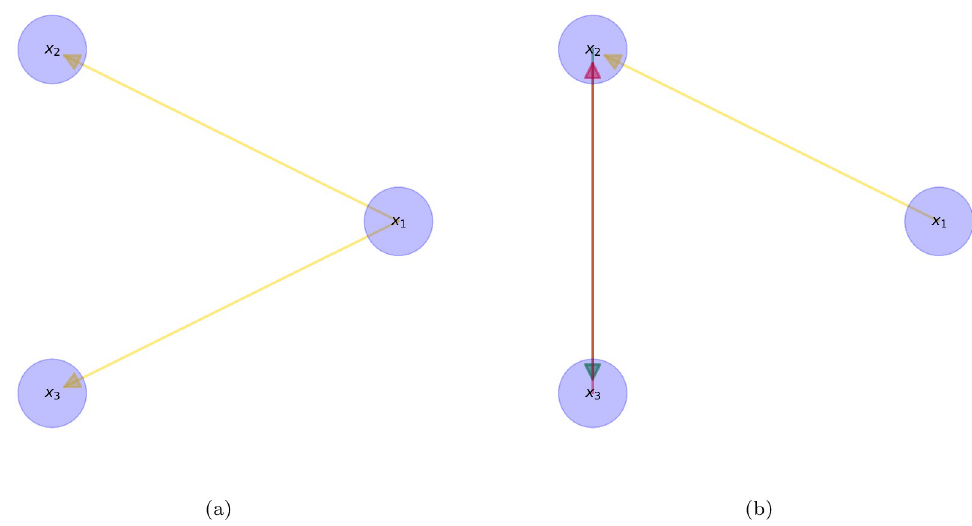
Fig 1. System 1. (a) Represents the STE detected interactions (b) Represents the Granger causality detected